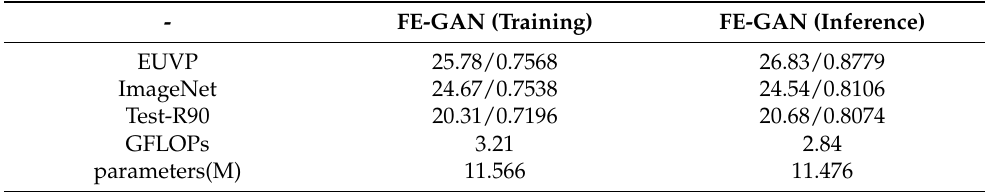
Table 12. FE-GAN (without-re) represents the model used in the inference stage. The metrics under the dataset represent PSNR and SSIM,